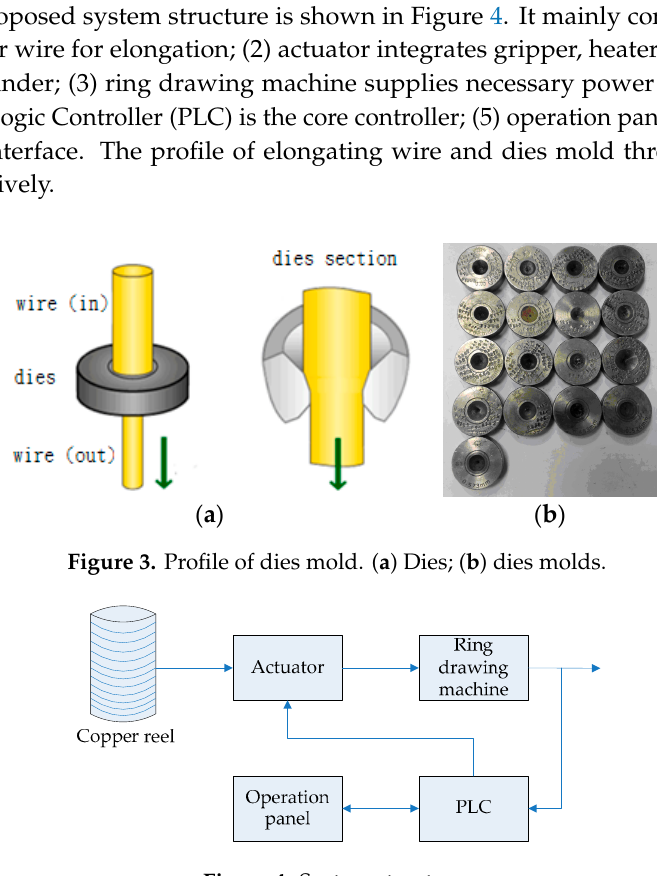
Figure 4. System Figure 4. System structure. Figure 4. System structure.